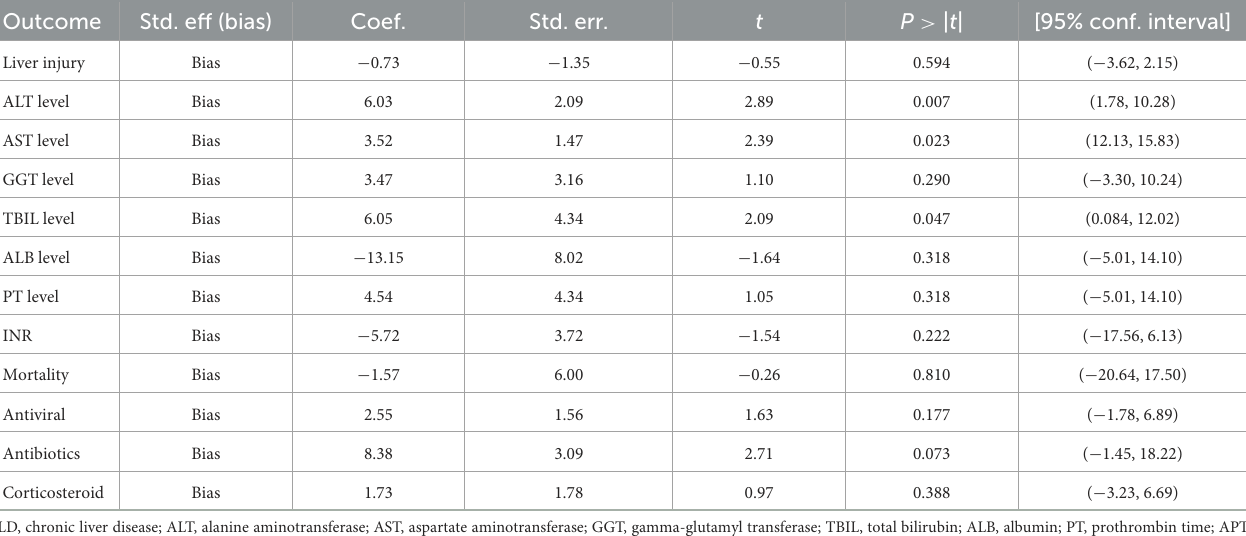
TABLE 1 Egger’s test of the studies included in the meta-analysis.